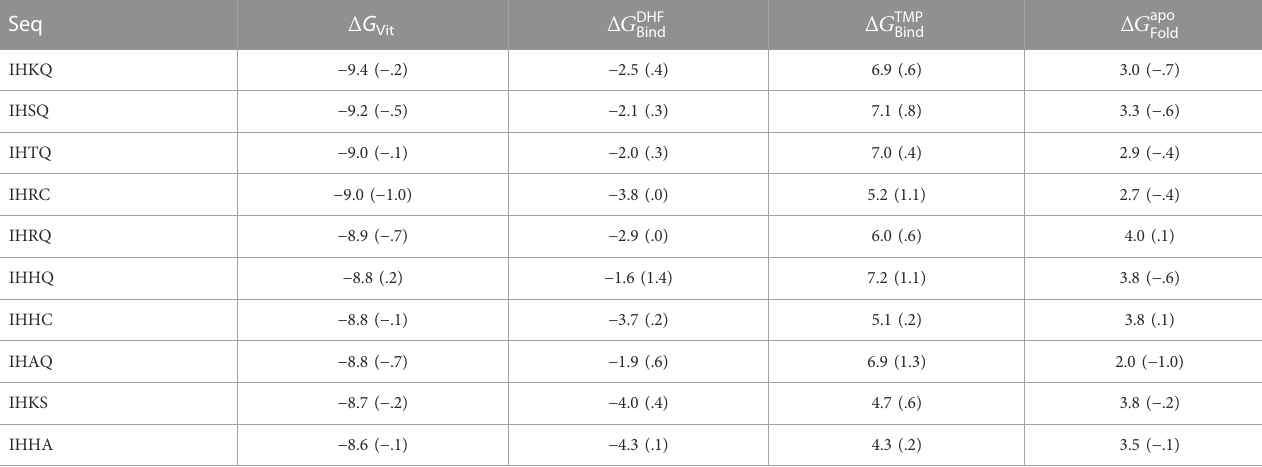
TABLE 4 Top variants from quartet design of positions 23 – 28 – 29 – 31.